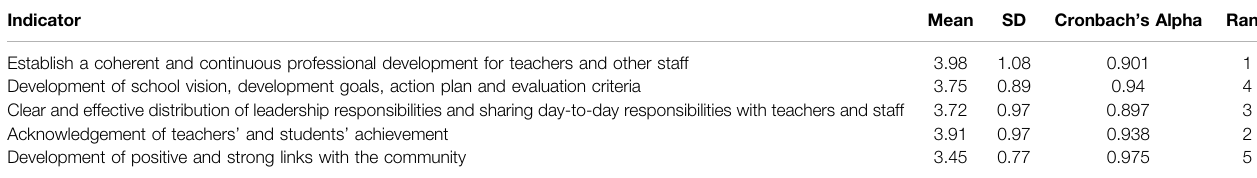
TABLE 5 | Common Leadership Qualities of Successful School Head Teachers.